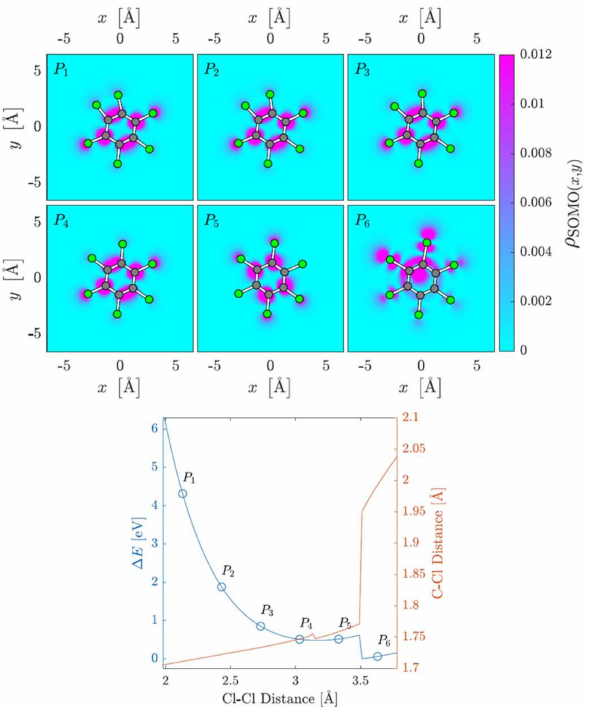
Figure 6. SOMO densities at six different C–Cl internuclear bending distances and the corresponding potential energy